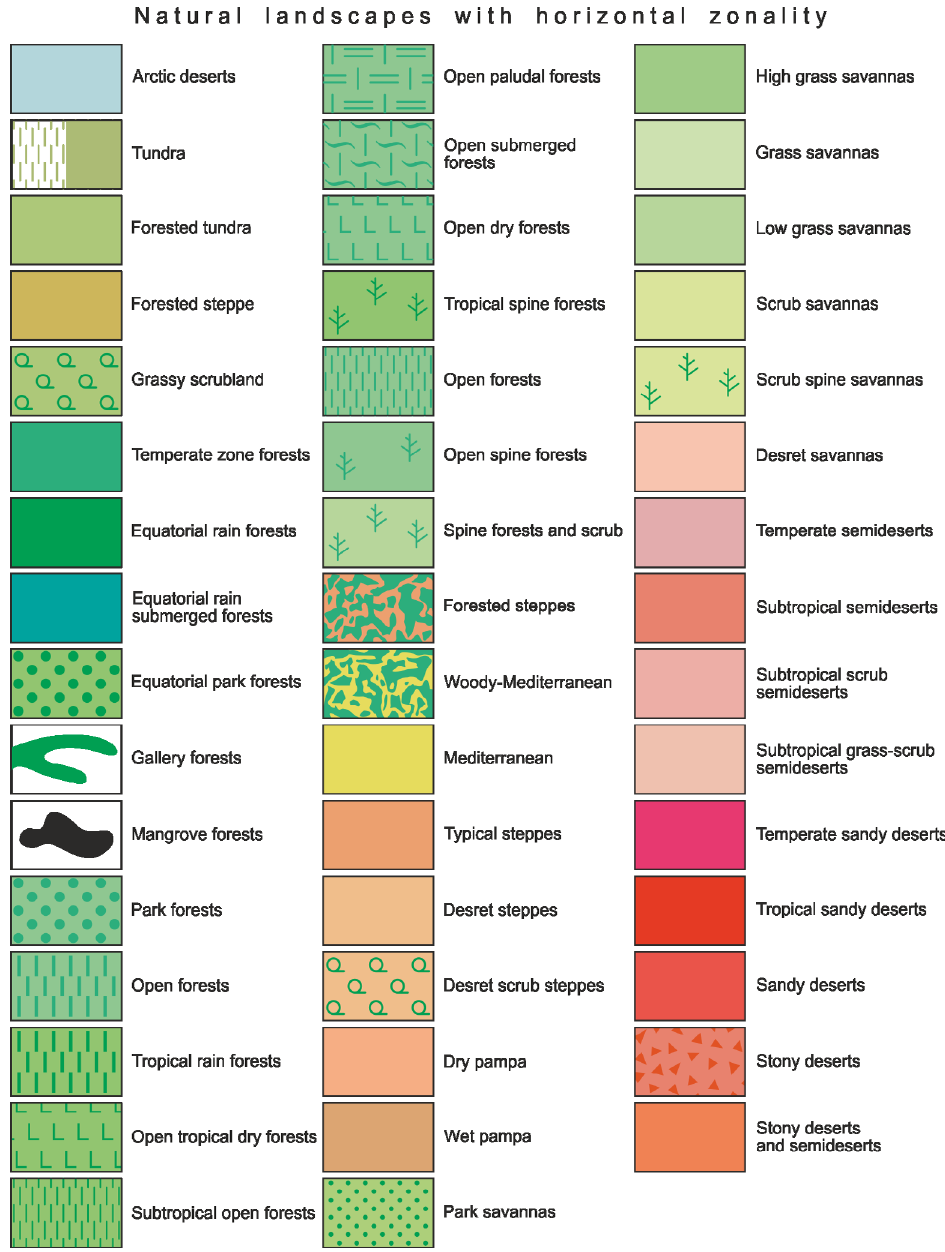
Fig. 2. List of cartographic patterns used by F. Uhorczak to present natural landscapes with horizontal zonation (the authors’